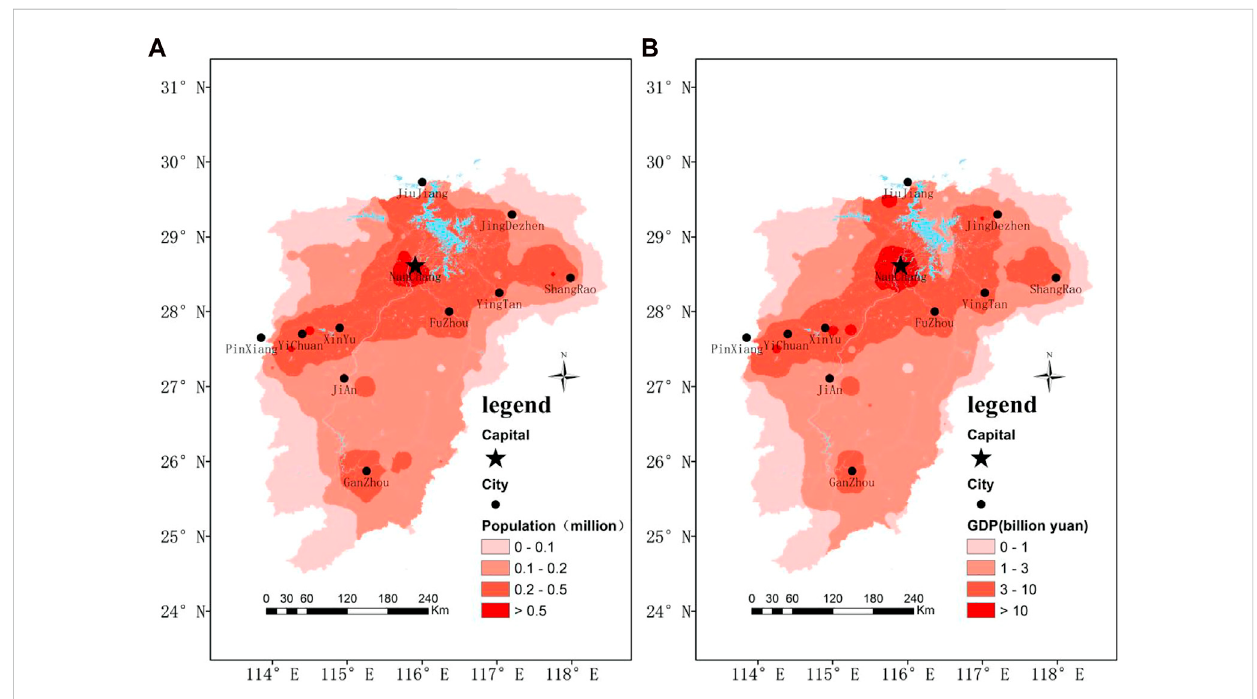
Annual average rate of increase in (A) population and (B) GDP in the Poyang Lake Basin (1984 –